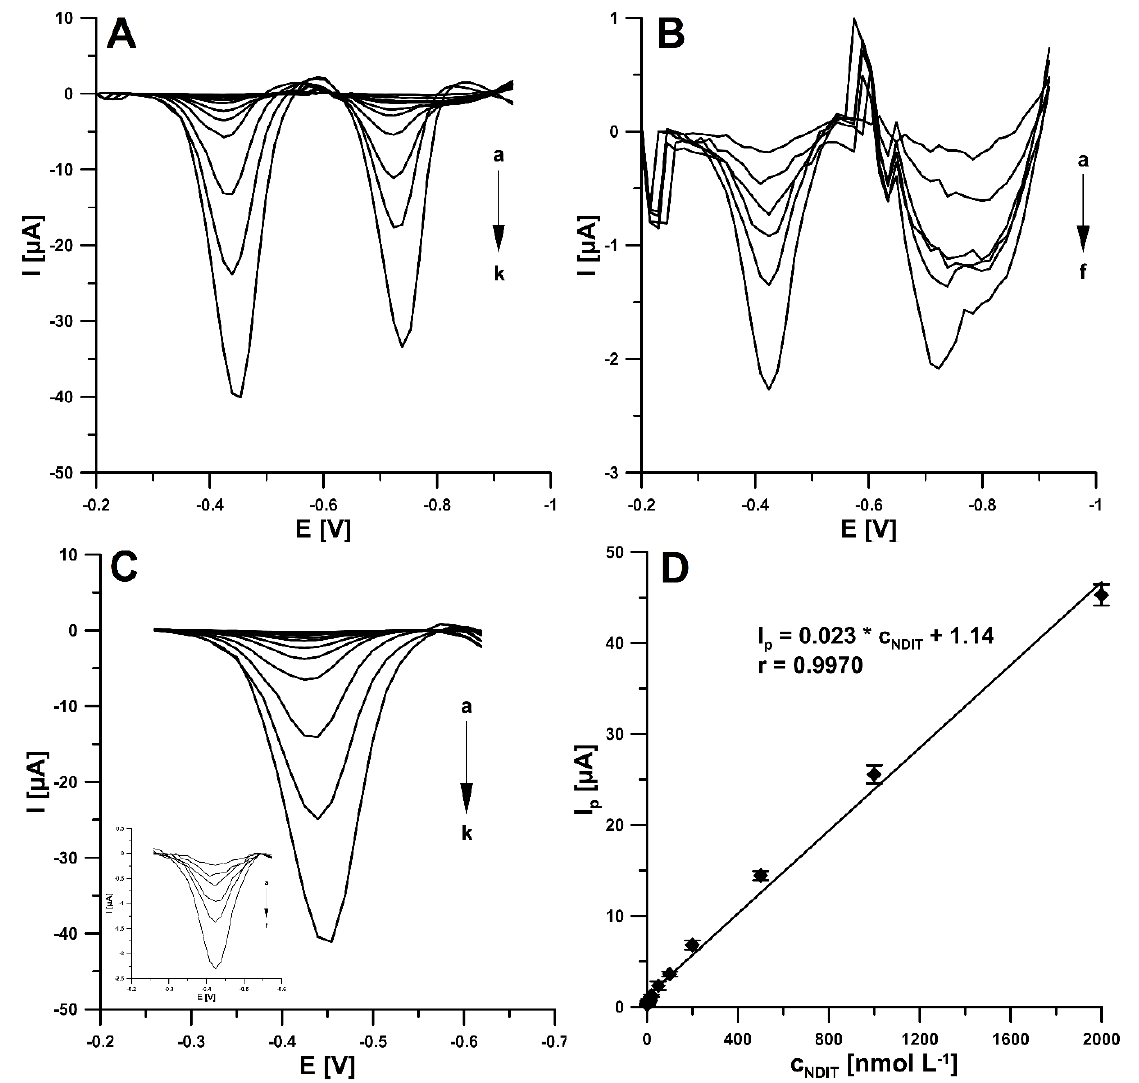
Figure 8. DPAdSV curves registered at the SPCE/SDS in 0.01 M solution of HNO 3 containing 10 mg/L SDS and increasing concentrations of NDIT: ( A ) (a) 1, (b) 2, (c) 5, (d) 10, (e) 20, (f) 50, (g) 100, (h) 200, (i) 500, (j) 1000, and (k) 2000 nM; ( B ) (a) 1, (b) 2, (c) 5, (d) 10, (e) 20 and (f) 50 nM; ( C ) (a) 1, (b) 2, (c) 5, (d) 10, (e) 20, (f) 50, (g) 100, (h) 200, (i) 500, (j) 1000, and (k) 2000 nM; and insert in C) (a) 1, (b) 2, (c) 5, (d) 10, (e) 20, and (f) 50 nM. ( D ) Calibration plot of NDIT (peak 1). DPAdSV parameters: t of 45 s, Δ E of 175 mV, ν of 150 mV/s, and t m of 5 ms. The mean values of I p are given with the standard deviation for n = 3.